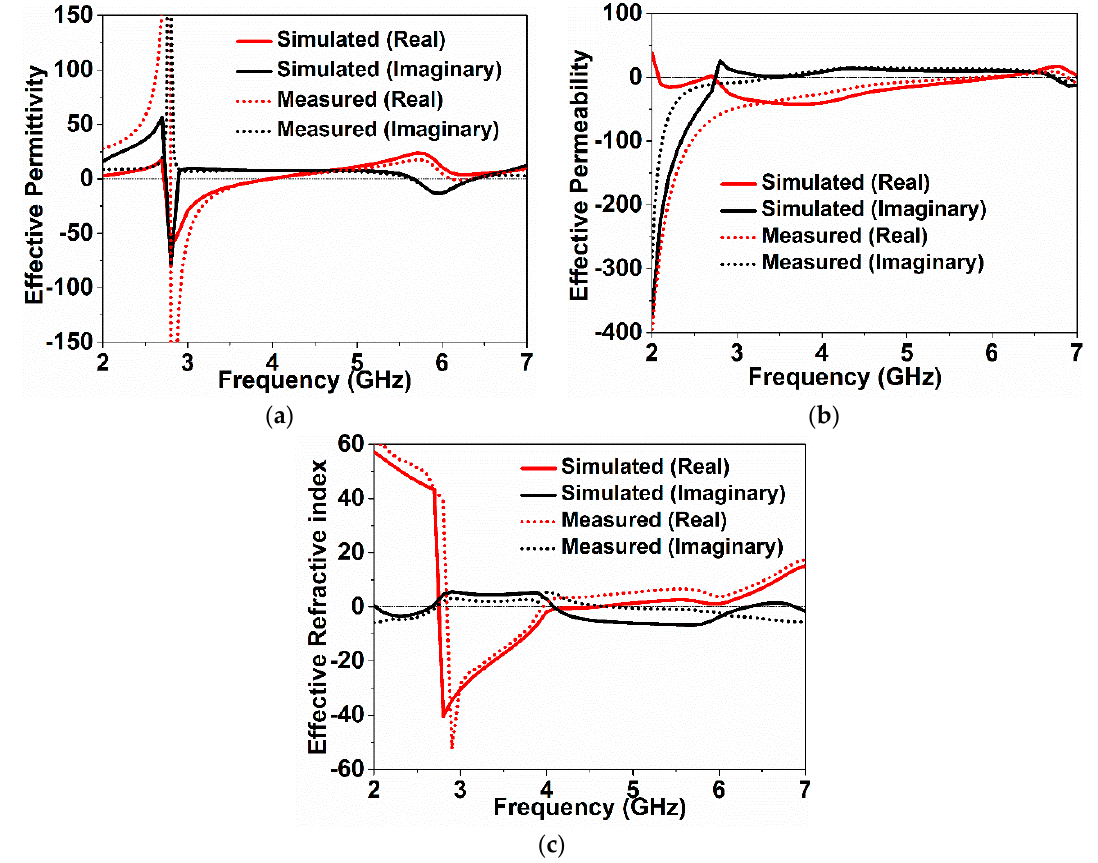
Figure 4. Effective parameters of the sensor: ( a ) permittivity, ( b ) permeability, and ( c ) refractive index. To describe the resonance type, the surface current distribution of the sensor was included. Figure 5 represents the surface current distribution of the sensor.